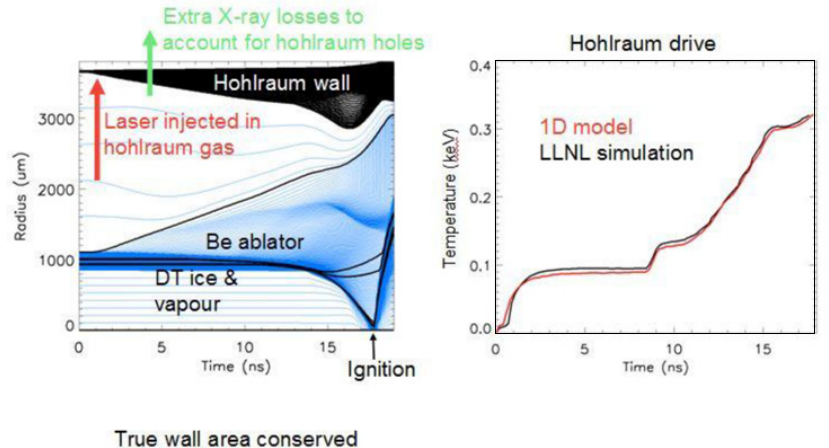
Figure 3. Simple 1D model for parameter studies.